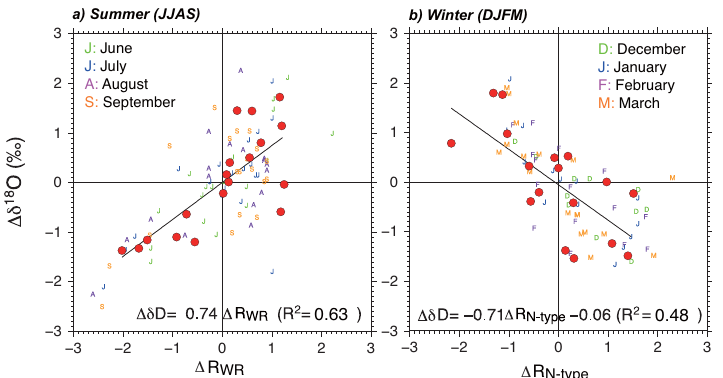
Figure 9. Anomalies of δ 18 O in precipitation at GNIP Tokyo station vs. (a) the ratio of warm rainfall to total summer precipitation ( R WR ) and (b) the ratio of the southern coastal precipitation ratio to the total winter precipitation ( R S-type ). Anomalies for monthly and seasonal averaged values were calculated by subtracting the long-term mean for that month and season and then dividing by the standard deviation. The long-term means were calculated from all available records (1962–1979) at GNIP Tokyo. Red circles represent the precipitation-weighted values in summer (from June to September) and in winter (from December to